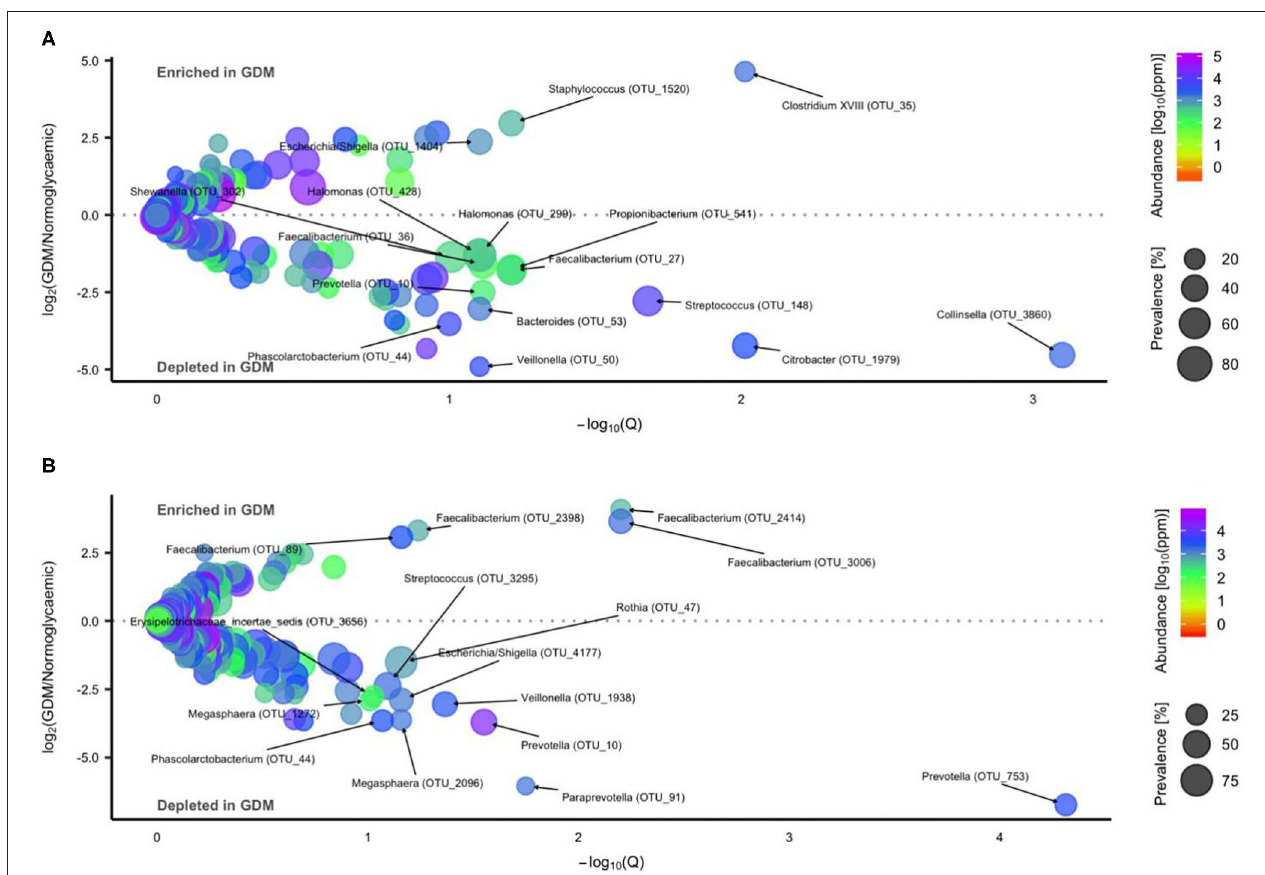
FIGURE 5 | Operational Taxonomic Units (OTU’s) differentially abundant in gut microbiota of newborns and infants of mothers with or without GDM. Volcano plot of estimated log 2 fold difference in OTU abundance according to maternal GDM status in newborns [ (A) n = 34 of mothers with GDM and n = 72 of mothers with normal gestational glucose regulation, at 1 week of life] and infants [ (B) n = 42 of mothers with GDM and n = 81 of mothers with normal gestational glucose regulation, at an average of 8.8 months of life) and corresponding Benjamin-Hochberg adjusted P-values (Q) from negative binomial Wald tests as implemented in the DESeq2 R package. Prevalence indicates percentage of children in which a given OTU is present. Abundance indicates mean relative abundance (reads per million). Taxonomic annotation of OTUs differentially abundant at a 10% false discovery rate is given at the genus level. Detailed information is presented in Supplementary Table 3 .